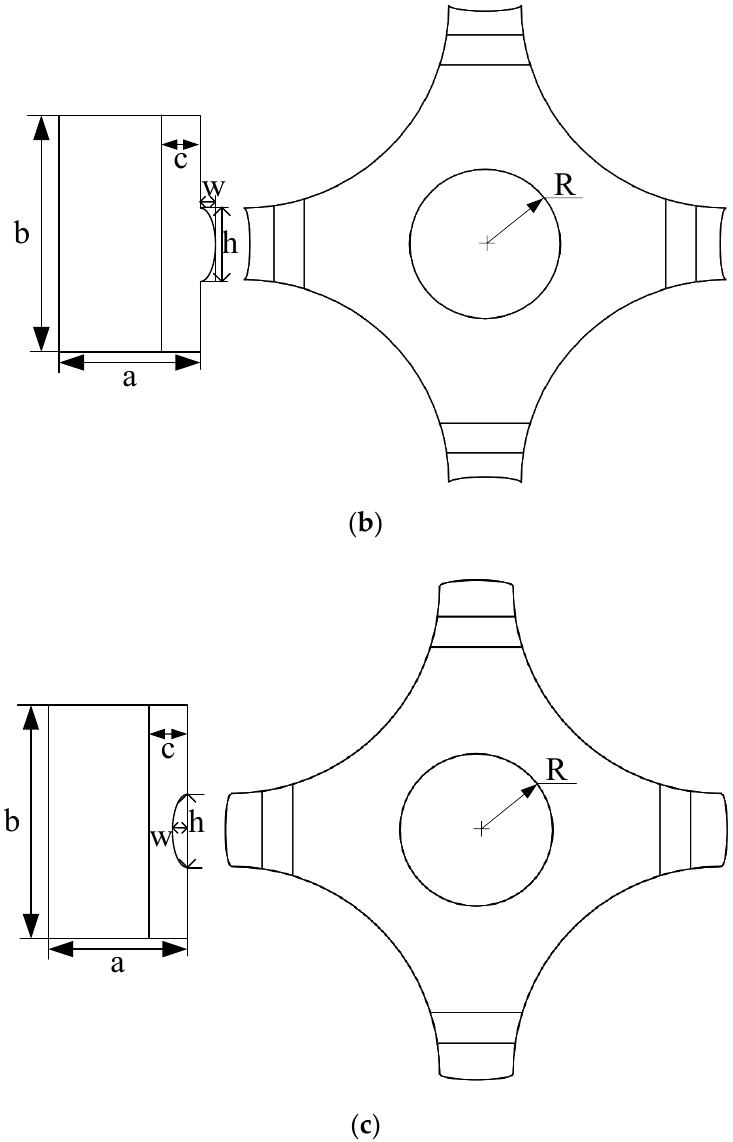
Figure 2. Rail-armature models of different configurations: ( a ) flat type rail—flat type armature; ( b ) convex elliptic rail—concave elliptic armature; ( c ) concave elliptical rail—convex elliptical armature. Table 2. Model geometric parameters.